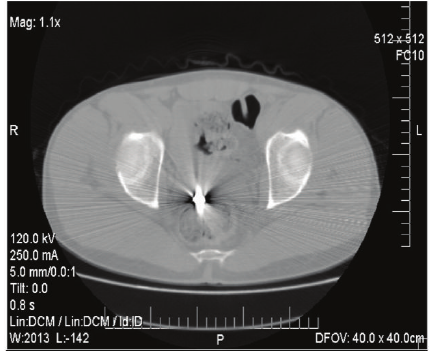
Figure 3: CT scan shows the bullet clear in the lower abdomen.